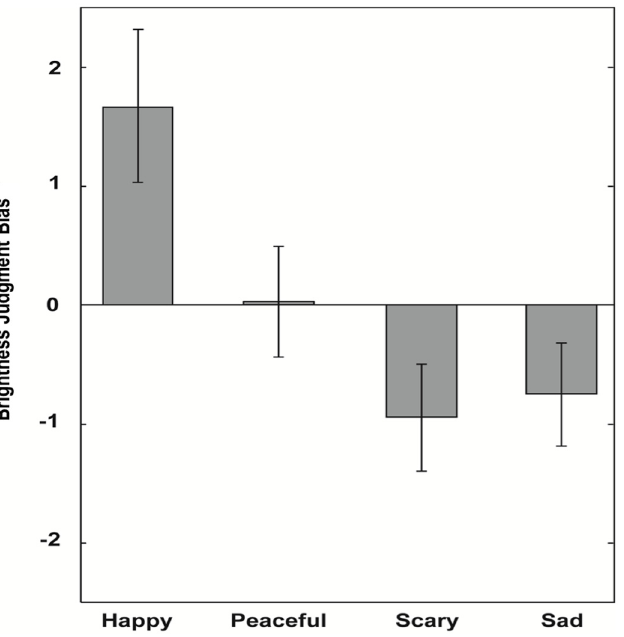
Fig 4. Results of Experiment 3. brightness judgment biases, separately for happy, peaceful, scary, and sad excerpts. Error bars indicate SE of the mean.